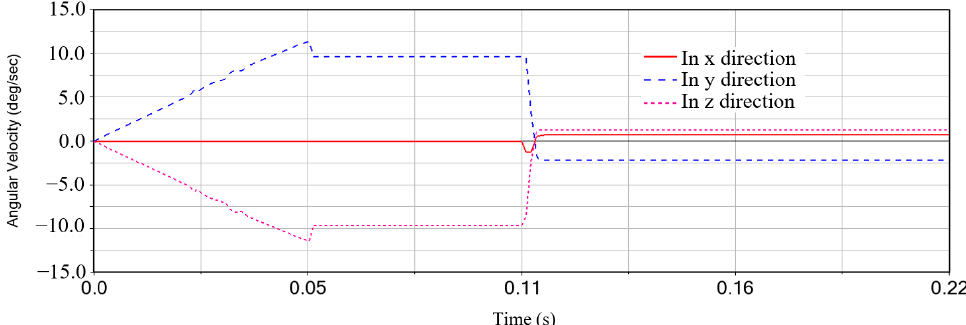
Figure 11. Separation angular speed of the 1U CubeSat.